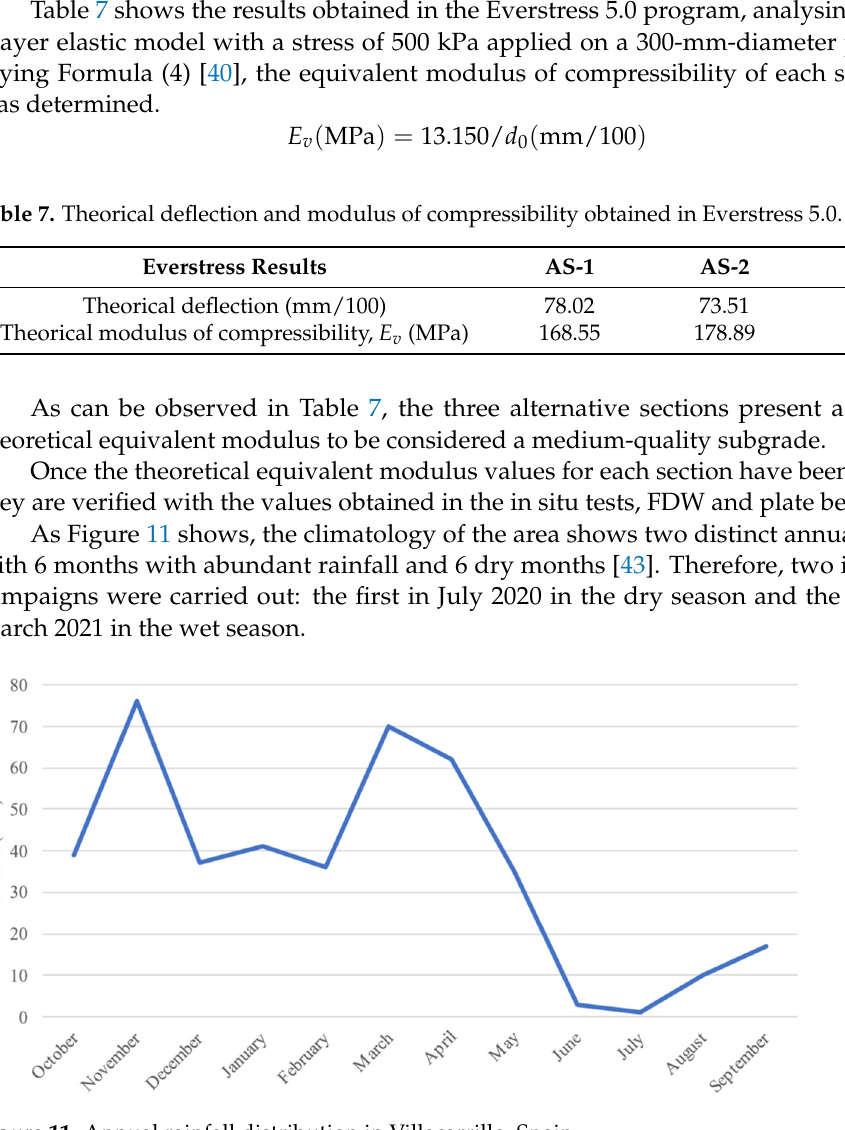
Figure 12. Deflection measurement in AS-1.